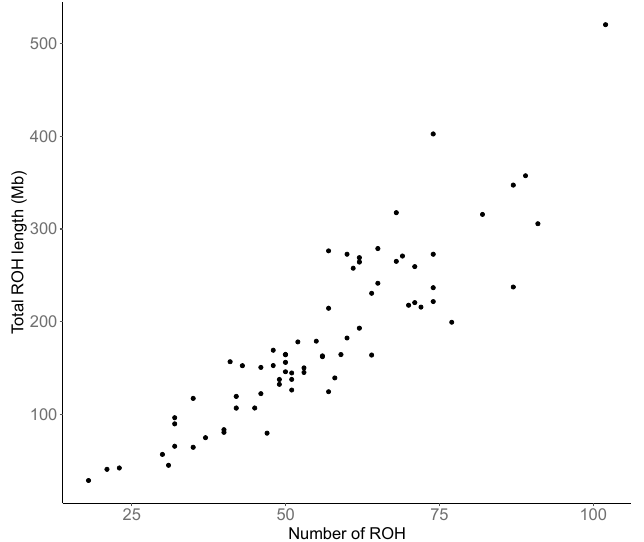
Figure 2. Relationship between the number of runs of homozygosity (ROH) found in each individual and their total length (Mb).